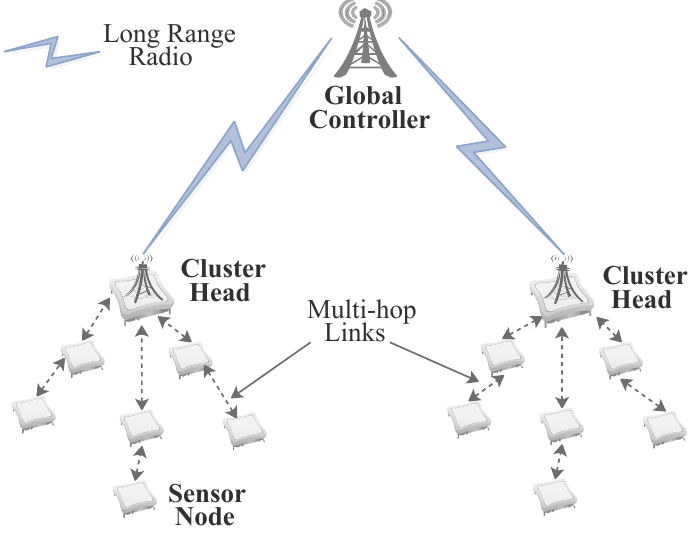
Figure 4. Hybrid radio